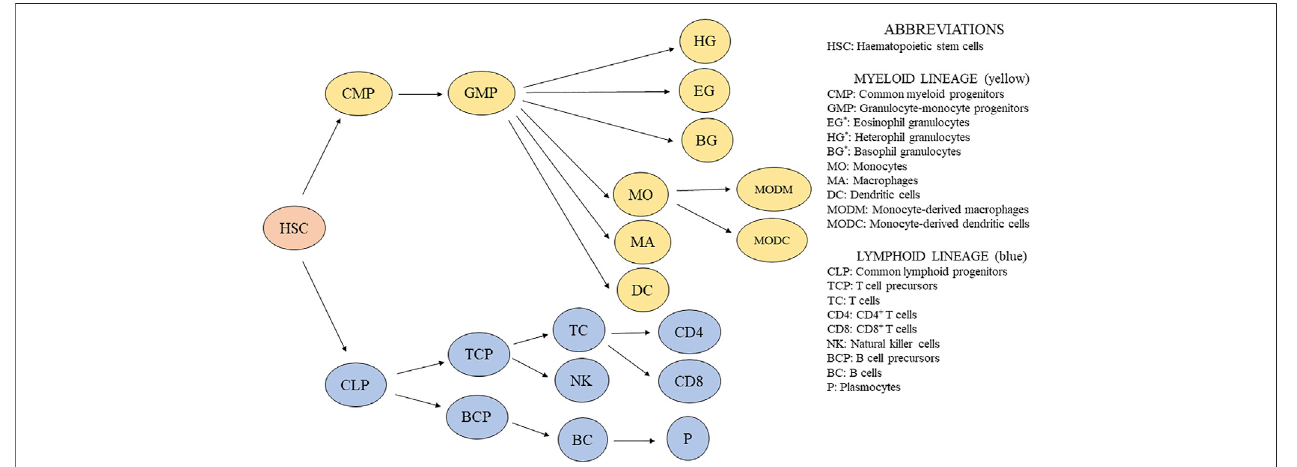
FIGURE1| Simpli fi ed schemeofimmunecelldevelopment inchickens. *Granulocytesareusuallydistinguishedby lightmicroscopy using blood smears, and their percentage is counted. Additionally, granulocytes are recognized based on their granularity by fl ow cytometry (Bilkova et al., 2017).